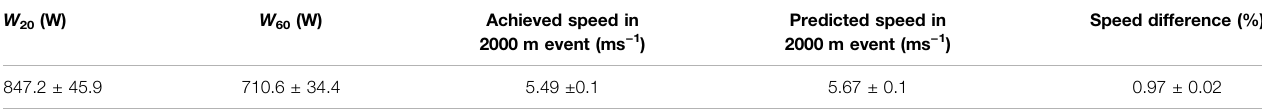
TABLE2| Themeasured W 20 and W 60 valuesofthe13additionaloldervolunteers(meanage21.1±0.8)andthepercentage differencebetweentheachieved2000mevent speed and model predicted speed for a 2000m event. W 20